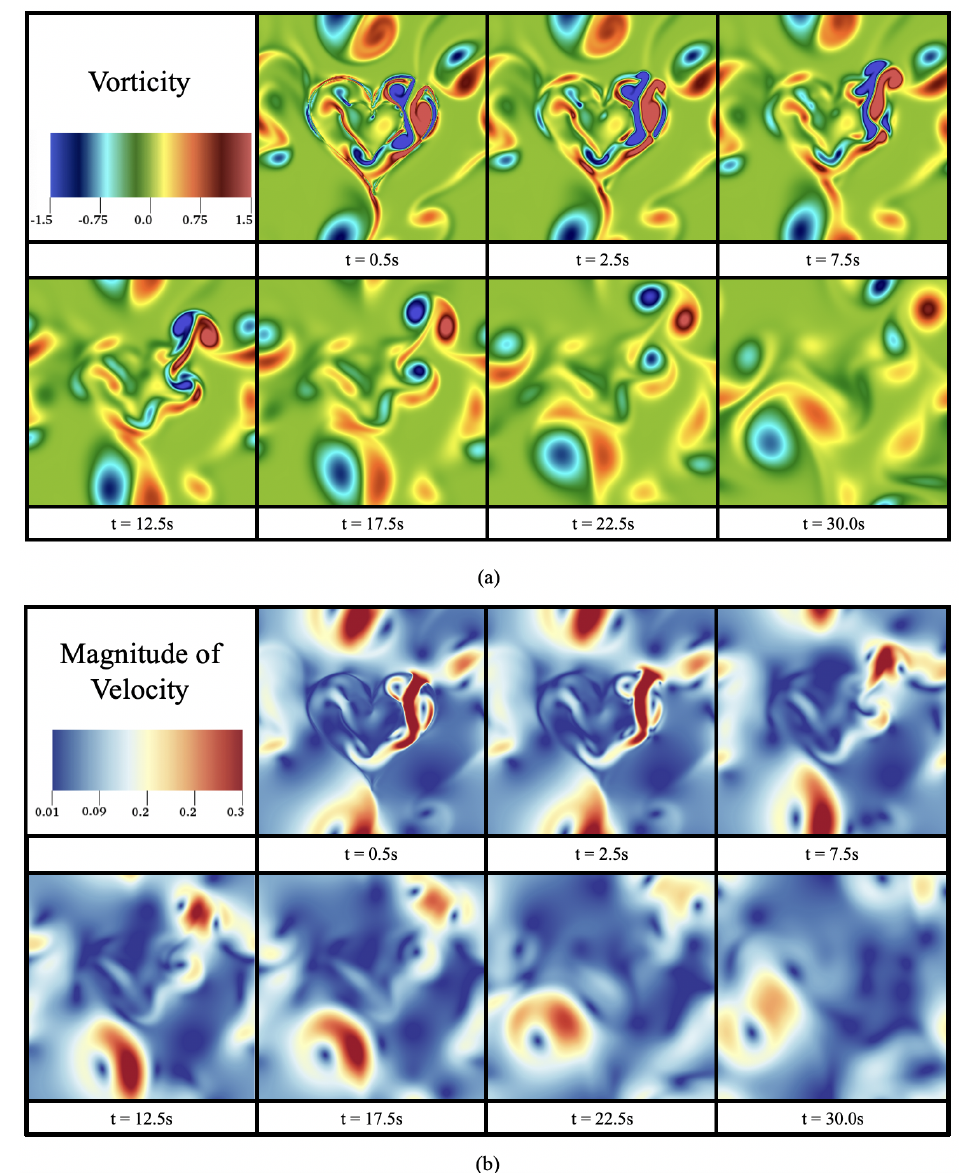
Figure 32. The evolution of ( a ) the fluid vorticity and ( b ) magnitude of velocity during the course of the